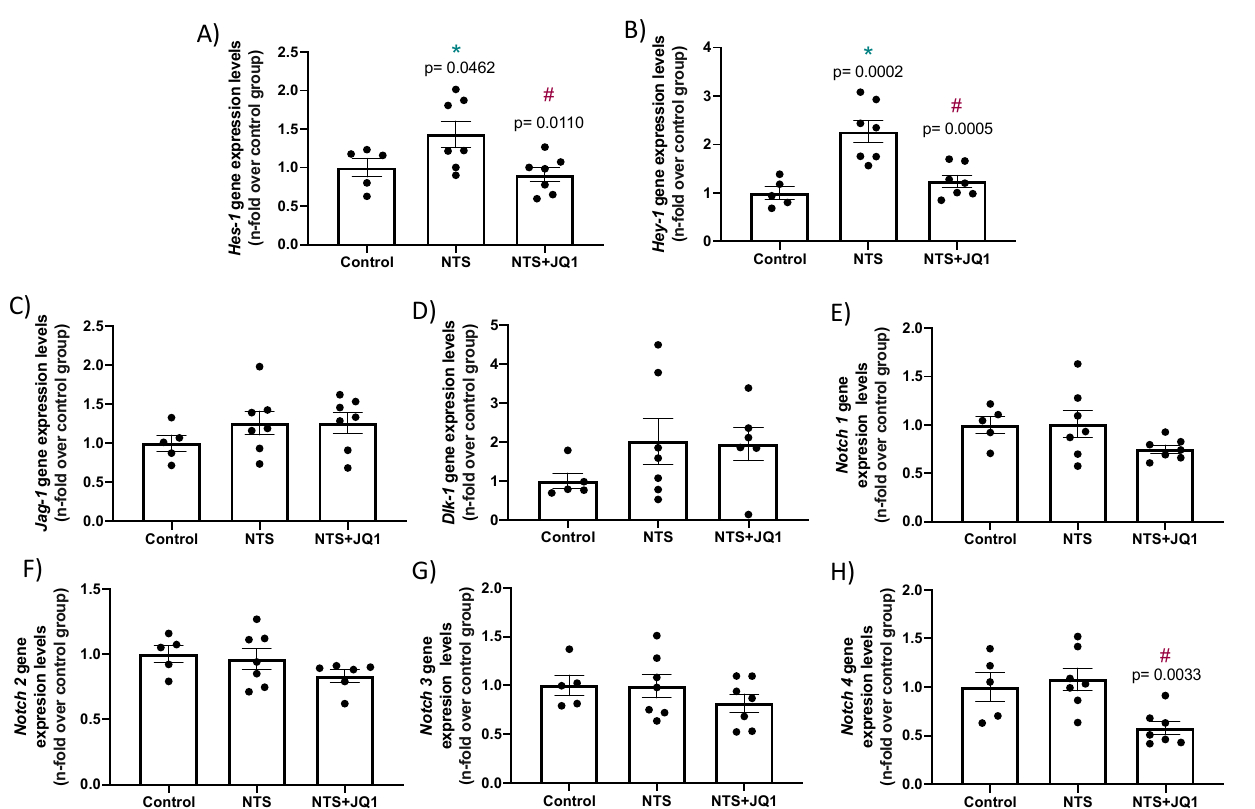
Figure 4. JQ1 inhibited NOTCH signaling pathway activation in experimental nephrotoxic nephritis. NTS mice were treated daily with JQ1 (100 mg/kg body weight per day) or vehicle. ( A ) RNA was isolated from frozen samples of whole kidney, and Hes-1 ( A ) Hey-1 , ( B ) Jagged-1 ( C ), Dlk-1 ( D ), Notch 1 ( E ), Notch 2 ( F ), Notch 3 ( G ) and Notch 4 ( H ) gene expression levels were evaluated by real-time qPCR. Data are expressed as the mean ± SEM of 5–7 animals per group. * p < 0.05 vs. control; # p < 0.05 vs. NTS-injected mice.